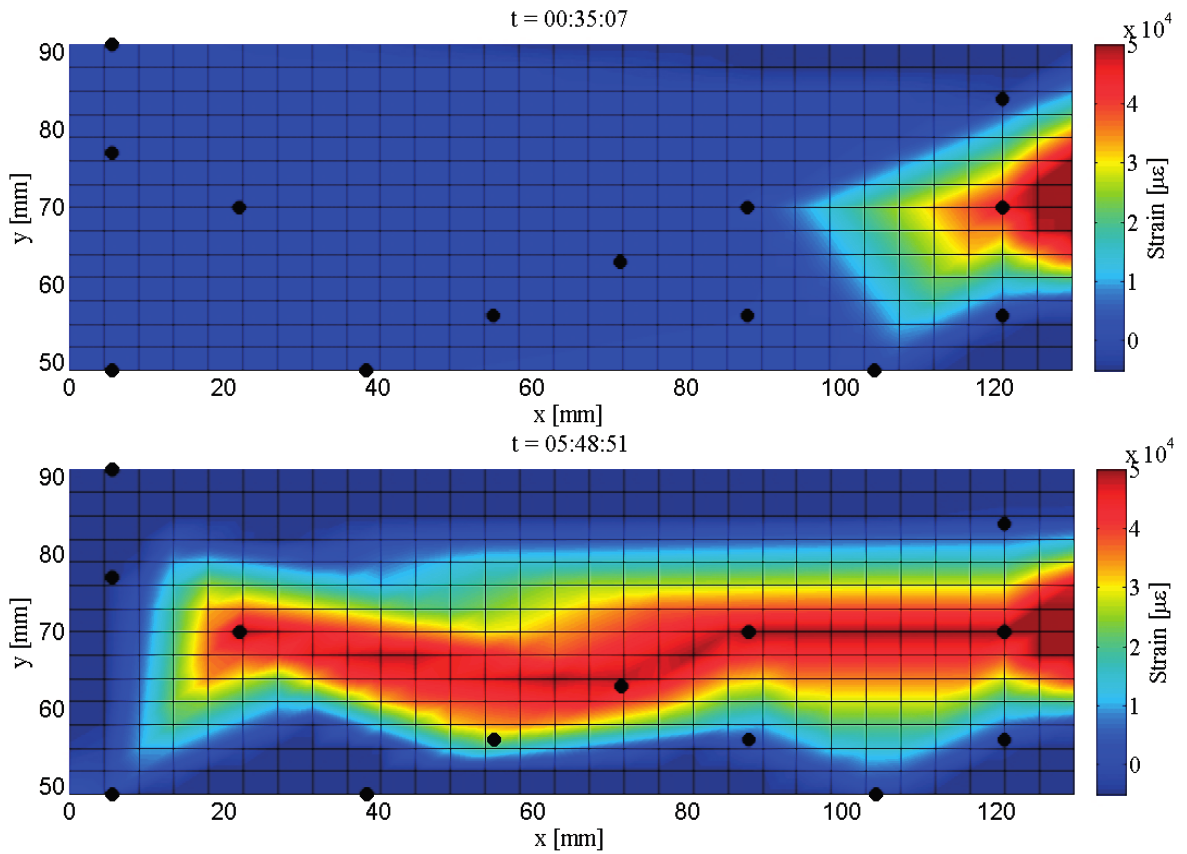
Figure 19. Maps of strain distributions in Plate #1 (Design 2); ( Up ): initialization of the crack (indicated in red color); ( Down ): crack extent at the end of the test.